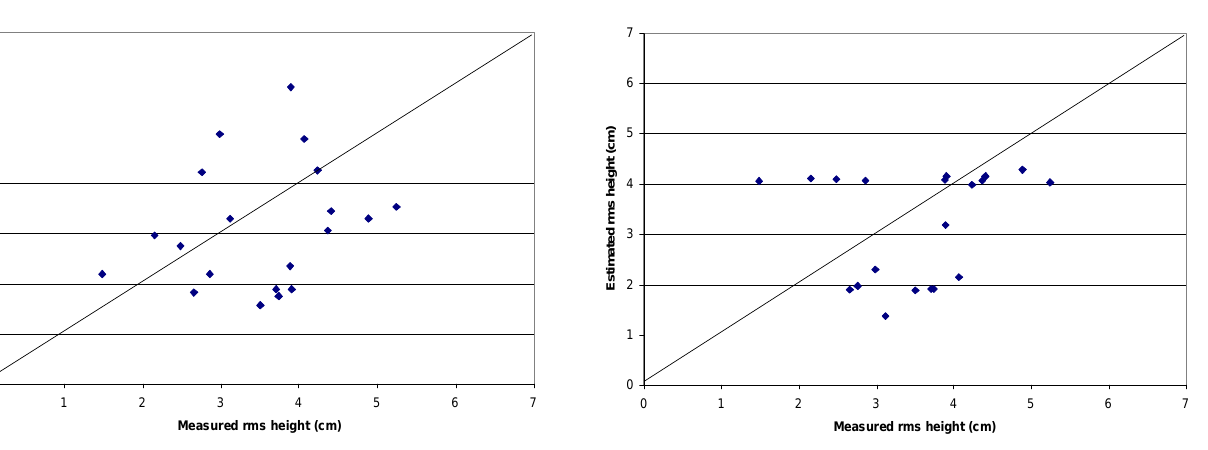
Fig. 8. Scatter plot of rms height measured and estimated by GOM. Table 1. Mean absolute error and coefficient of performance (CP 0 for surface parameters obtained by inversion